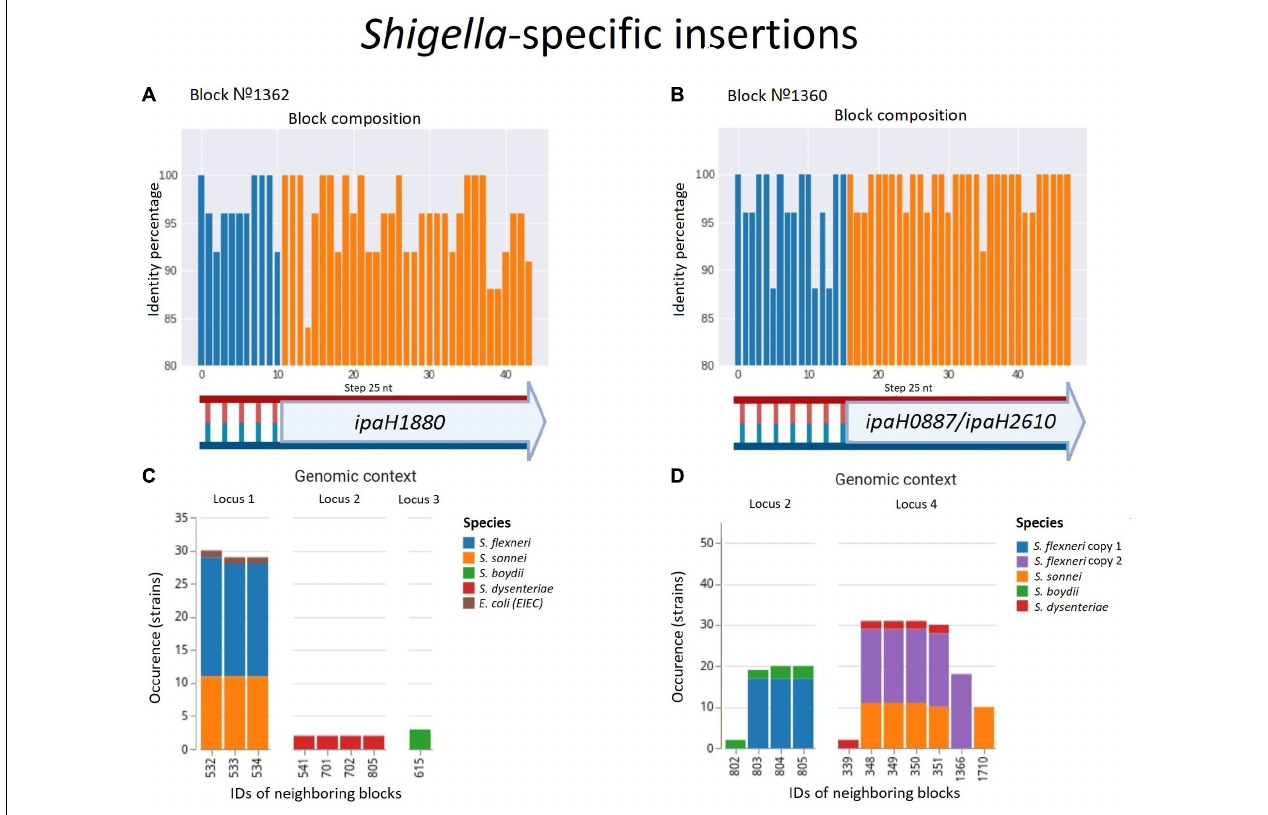
FIGURE 8 | Two parallel Shigella-specific insertions. (A,B) Both inserted blocks contain long non-coding regions with more than 85% identity and the ipaH genes encoding E-3 ubiquitin-ligases with different substrate-specific domains. The identity was calculated for nucleotide alignments of the synteny blocks separately with step 25 nt. (C,D) The location of the inserted blocks in different genomic contexts confirms an independent acquisition of the block by different Shigella lineages; in Shigella dysenteriae , block #1360 has been inserted twice at different loci. We took into consideration up to five of the nearest blocks, both in the upstream and downstream direction, at the distance not exceeding 10 kb. Colours correspond to Shigella lineages. The gene composition of the neighbouring blocks for both insertions is shown in Supplementary Table 5 .